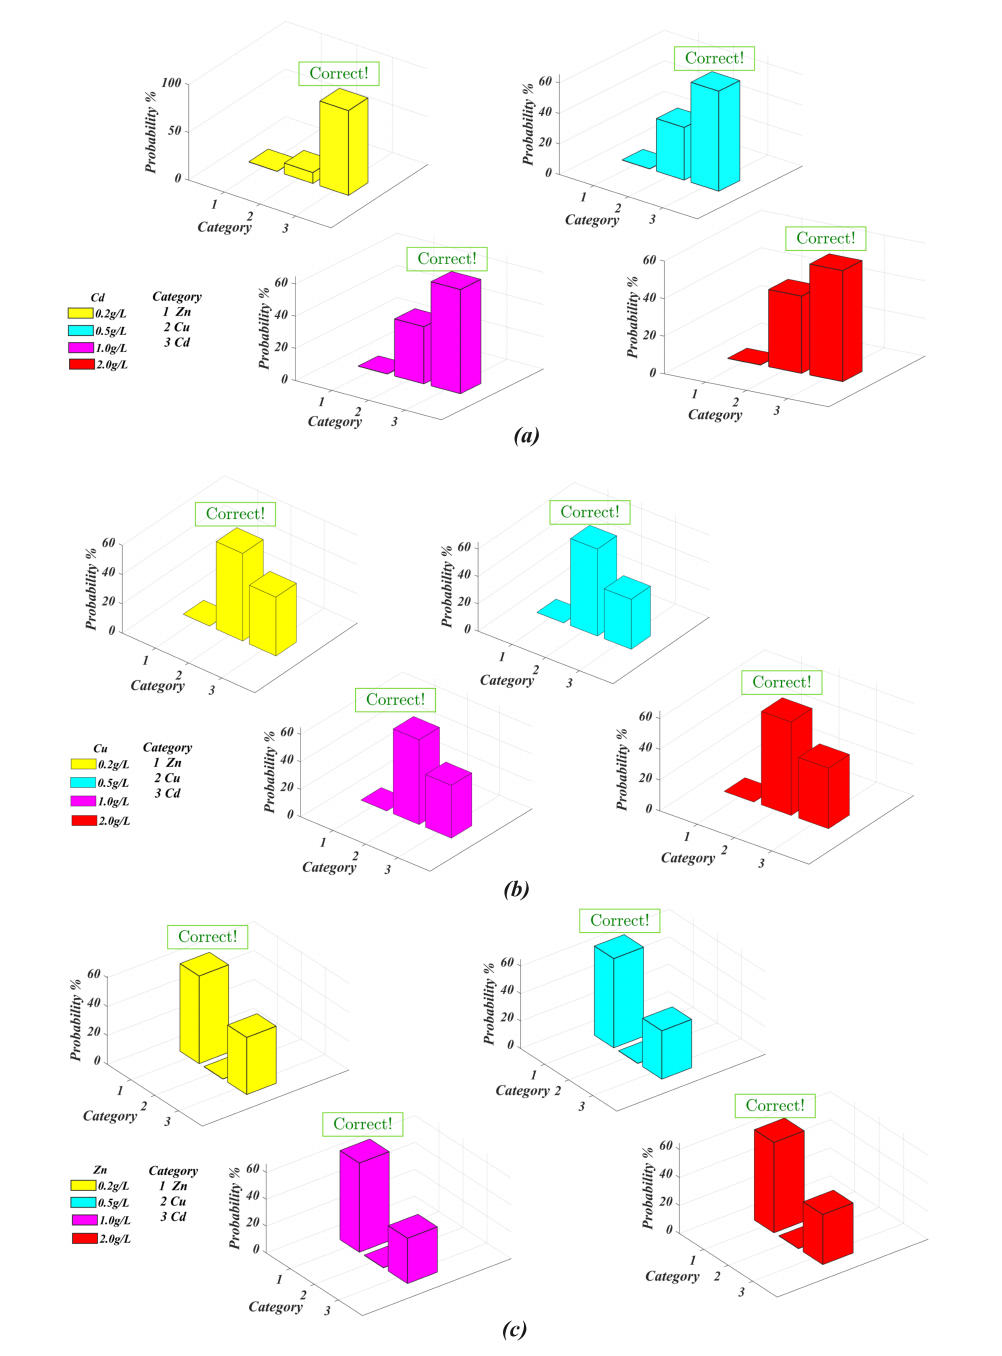
Figure 9. The results of the classification with HMID-NET. ( a – c ) are the probabilities of the classifica- tion of Cd 2 + , Cu 2 + , and Zn 2 + at the four concentrations in order, where category 1 is Cd 2 + , category 2 is Cu 2 + , and category 3 is Zn 2 + . The values in the bar chart refer to the magnitude of the probability that the sample belongs to that